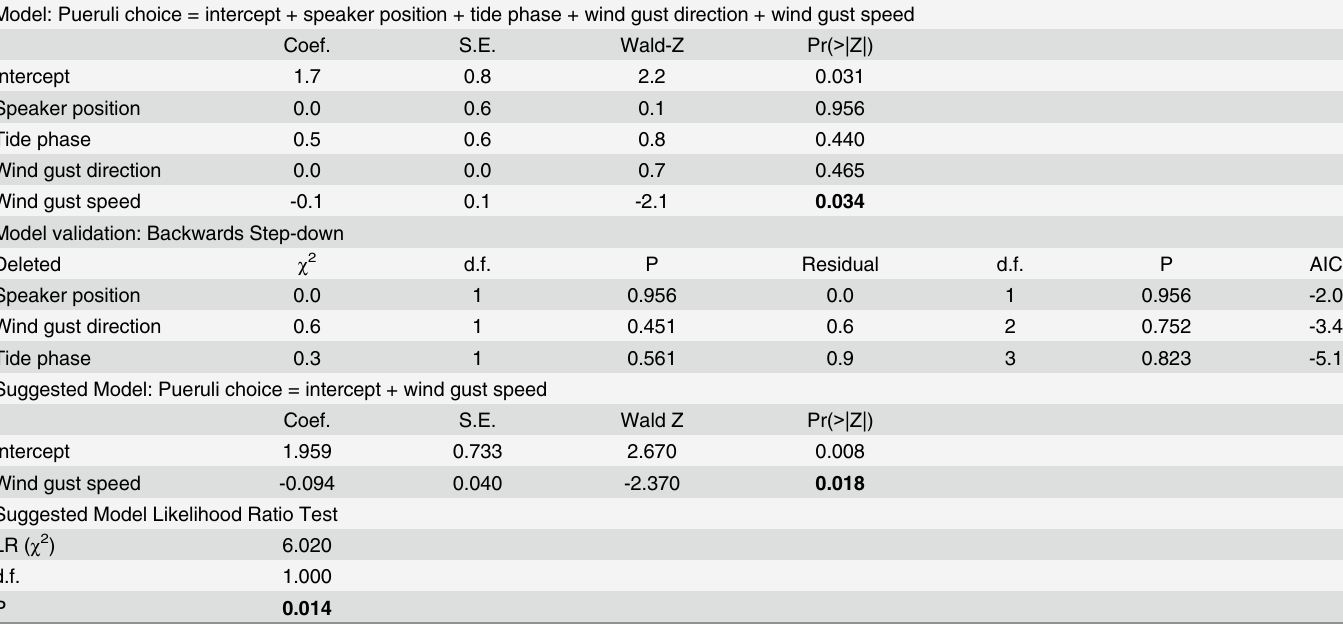
percent (n = 29) of the pueruli moved toward the artificial source of reef sound when wind Table 2. Logistic regression of the directional choice of Jasus edwardsii pueruli in relation to the speaker position and environmental variables (tide phase, wind gust direction and wind gust